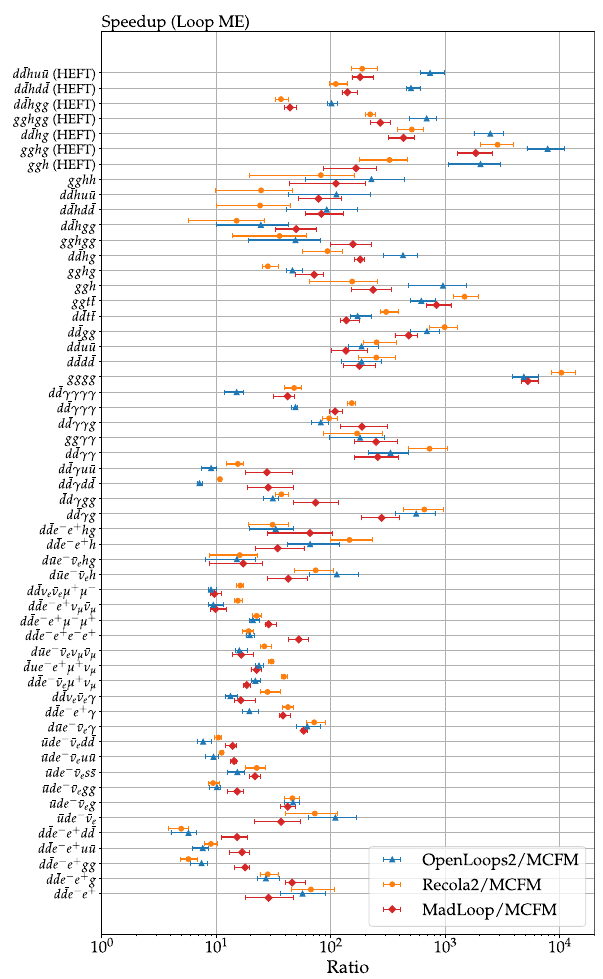
Fig. 1 CPU time ratio of O PEN L OOPS , R ECOLA , and M AD L OOP 5 to M CFM at the level of loop matrix